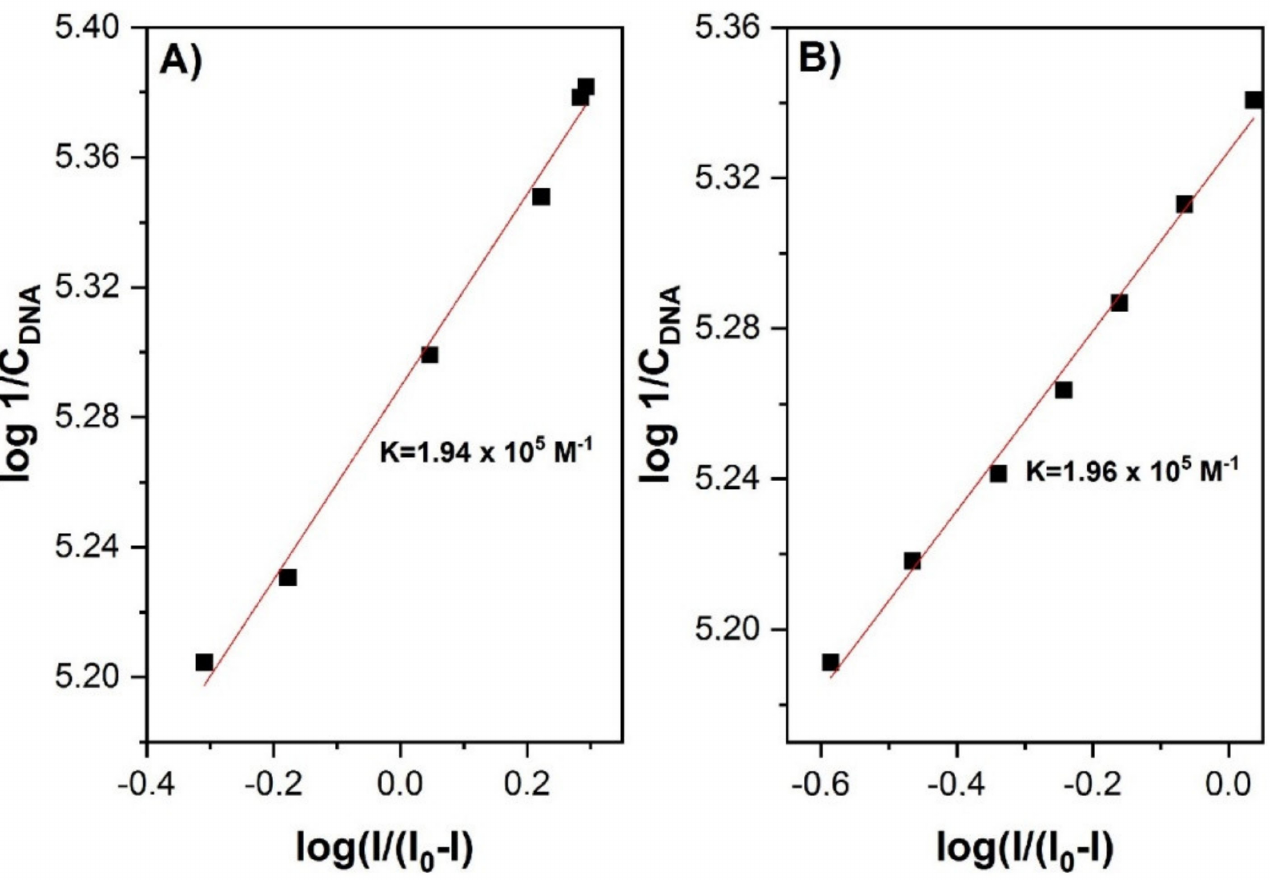
DSB and the DSB–DNA adduct, respectively, which indicated the drug–DNA binding. Moreover, the heterogeneous electron transfer rate constants (k s ) and the electrode surface concentration for the DSB and the DSB–DNA complex were calculated.